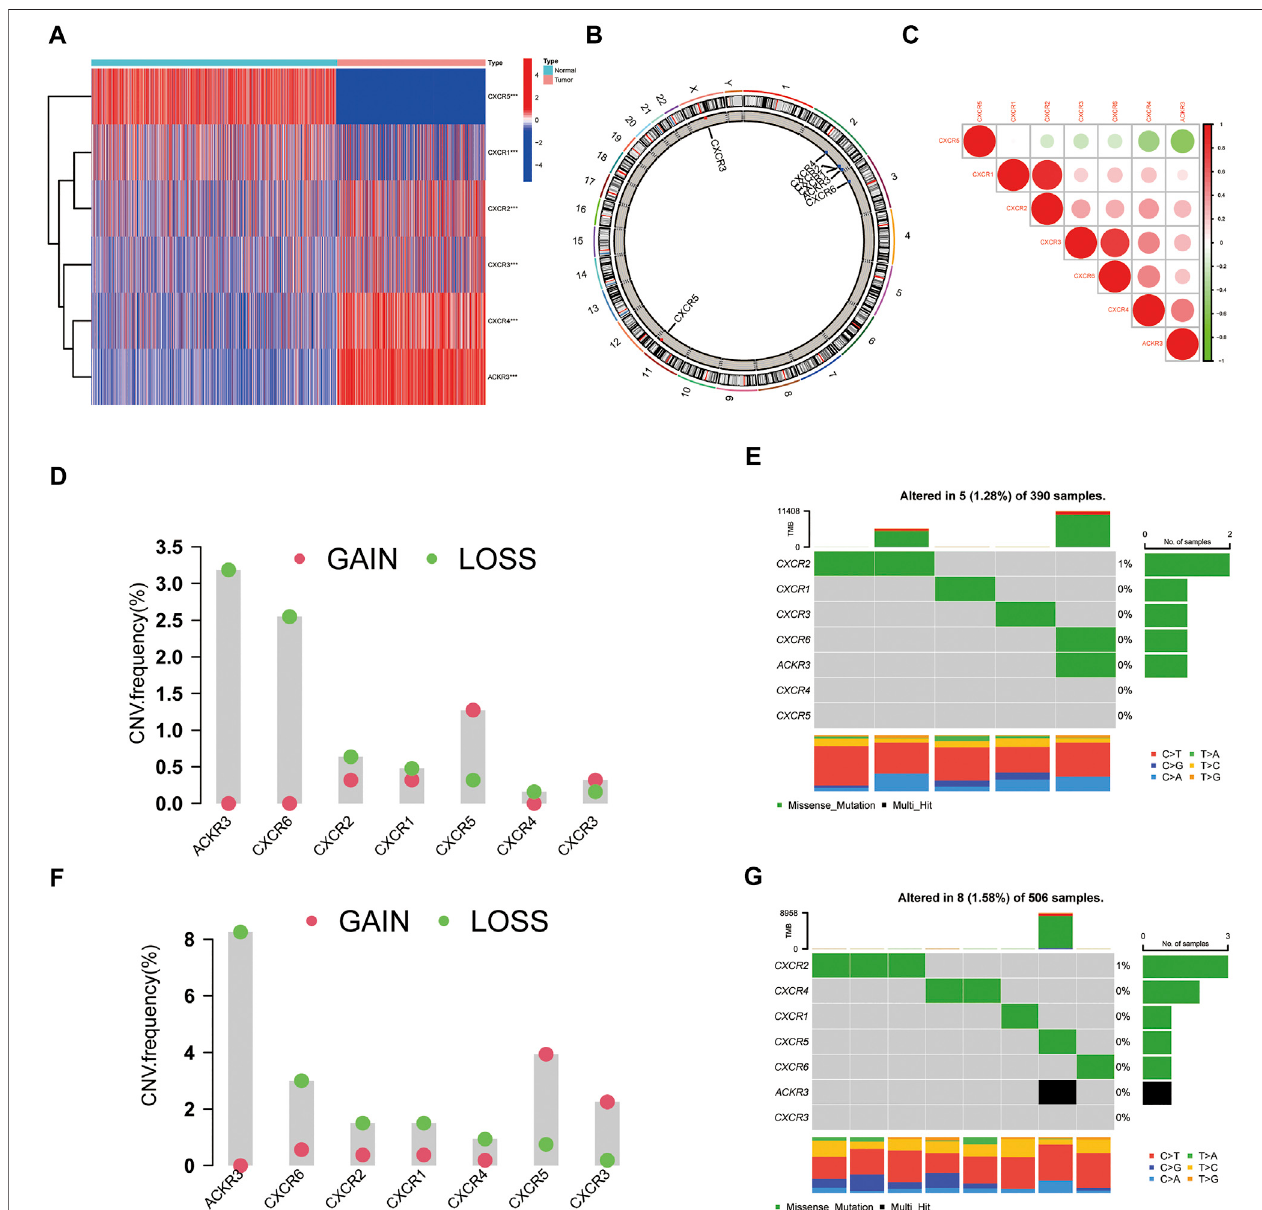
FIGURE1| TranscriptionalandGeneticalterationsofCXCRsinglioma. (A) HeatmapofsixdifferentialexpressionCXCRsingliomatissuesandnormalbraintissues (red: high expression; blue: low expression). Asterisk indicates: t test, * p < 0.05, ** p < 0.01 and *** p < 0.001 compared to the normal brain tissues. (B) The location of CNV alteration ofsevenCXCRmoleculeson 23chromosomes. (C) CorrelationsbetweensevenCXCR genes.Thedarkertheblue, thestronger thenegative correlation, and the darker the red, thestronger the positive correlation. CNV distributionof CXCRs in GBM (D) and LGG (F) tumor samples.Theheightof thebar represented the total alteration frequency. The landscape of somatic mutation frequency of CXCRs in GBM cohort (E) and LGG cohort (G) . The somatic mutation landscape of the GBM cohort (E) and LGG cohort (G) . Each column represented an individual sample. The bar graph on the right indicated the mutation frequency of each gene. The upper barplot showed the